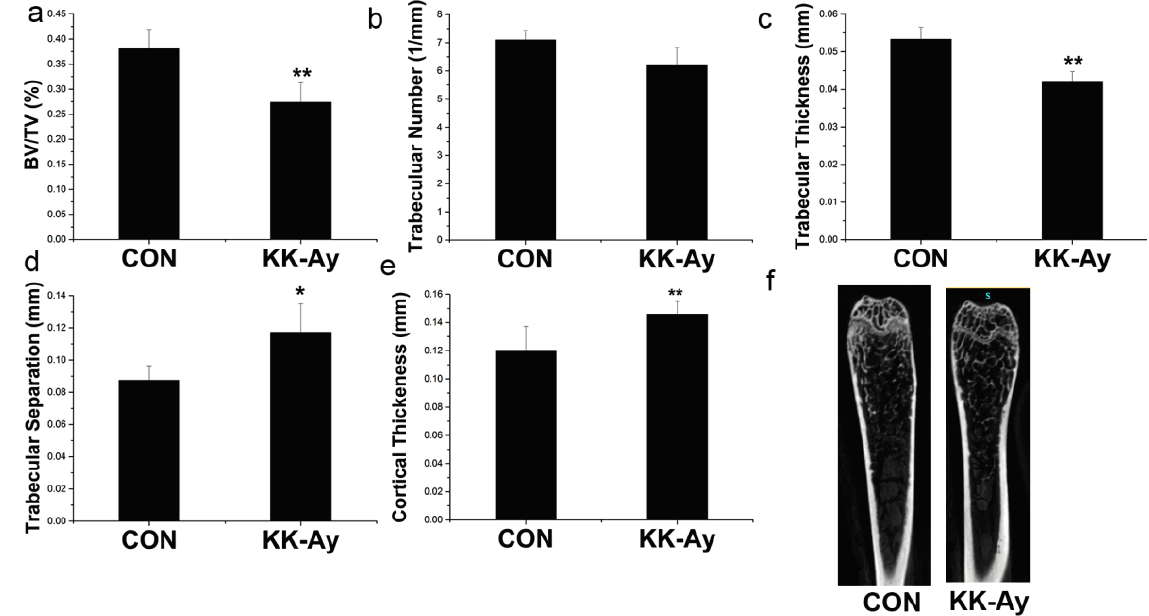
Figure 4. Bone micro-architecture in control (CON) and KK-Ay mice. All parameters are micro-computed tomography derived. ( a ) BV/TV (bone volume/total volume); ( b ) trabecular number; ( c ) trabecular thickness; ( d ) trabecular separation; ( e ) cortical wall thickness; ( f ) µCT images of the distal femur; n = 4–5, ** p < 0.01 vs. CON; * p < 0.05 vs. CON. The data are shown as the means ±